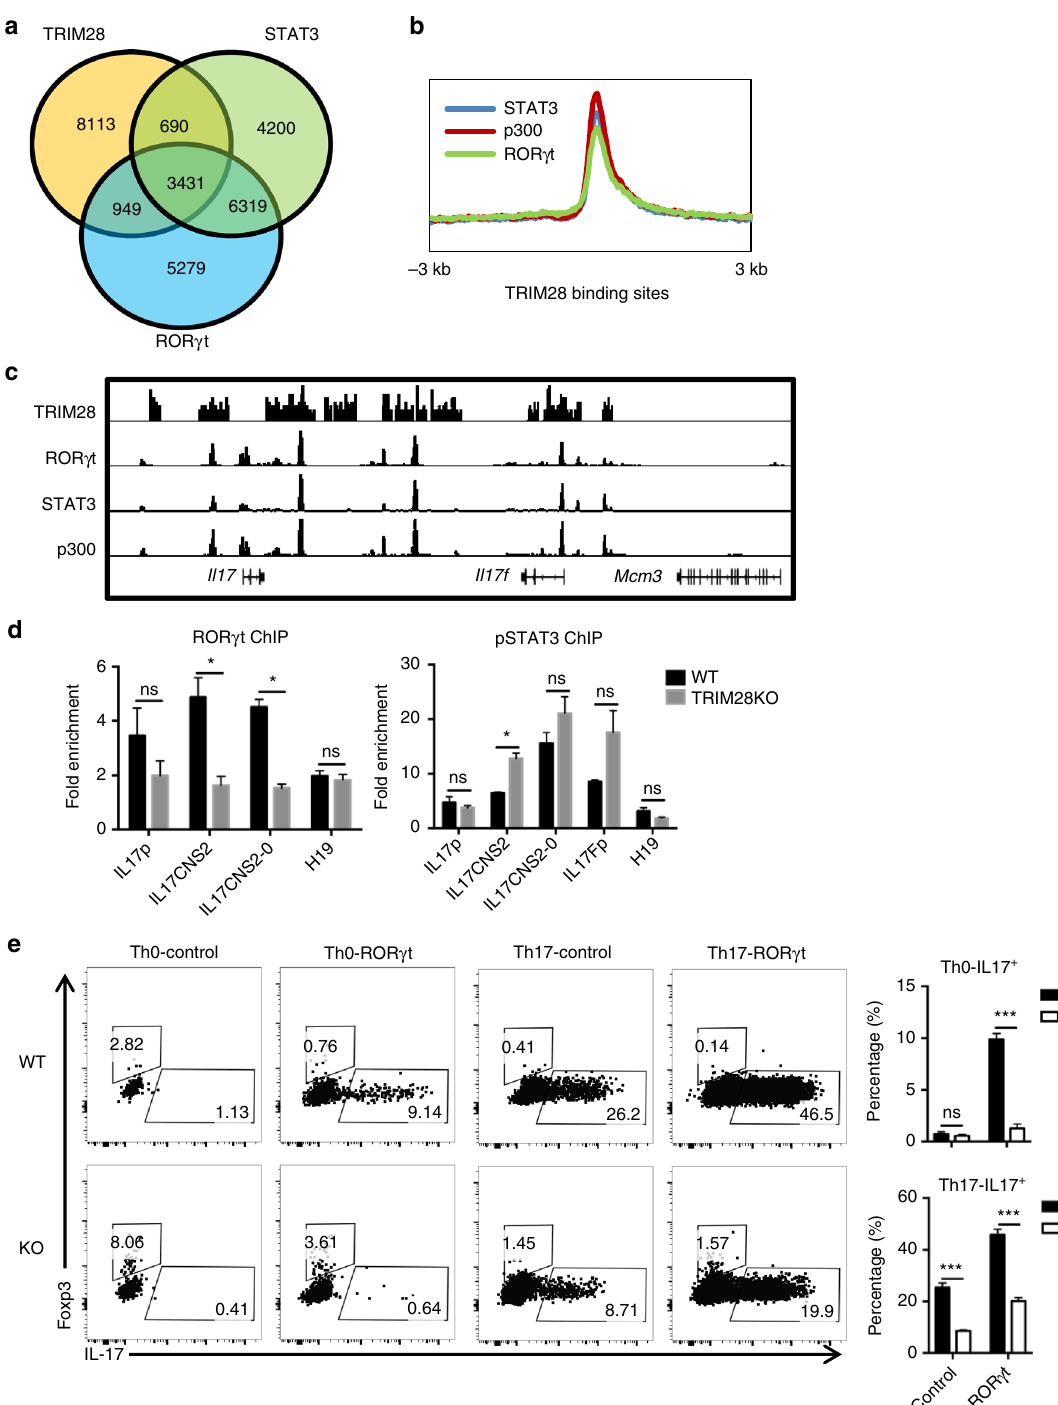
Fig. 6 TRIM28 functions as a cofactor for ROR γ t and STAT3. a Overlay of TRIM28 binding peaks with that of ROR γ t and STAT3 in Th17 cells. b Genome- wide distributions of binding peaks of ROR γ t, STAT3, and p300 at TRIM28 binding sites. c IGV browser view of ROR γ t, STAT3, and TRIM28 binding peaks at the Il17-Il17f gene locus. d Binding of ROR γ t and STAT3 to the Il17-Il17f gene locus in WT and Trim28 − / − Th17 cells cultured at TGF- β plus IL-6 condition. e Overexpression of ROR γ t in WT or TRIM28 KO CD4 + T cells polarized under neutral (Th0) or Th17 (TGF- β plus IL-6) conditions. d , e The experiments were repeated 2 – 3 times with consistent results, and Student ’ s t test was used for the statistical test (ns = not signi fi cant; * p < 0.05, ** p < 0.01, *** p <